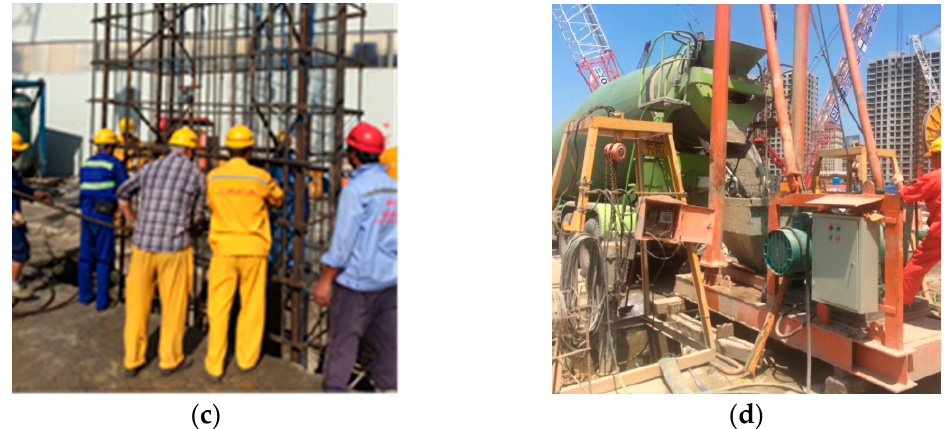
Figure 1. Construction site pictures. ( a ) Notch of the underground diaphragm wall; ( b ) lateral pressure gauge on the reinforcement cage; ( c ) hoisting the reinforcement cage; ( d ) pouring concrete.